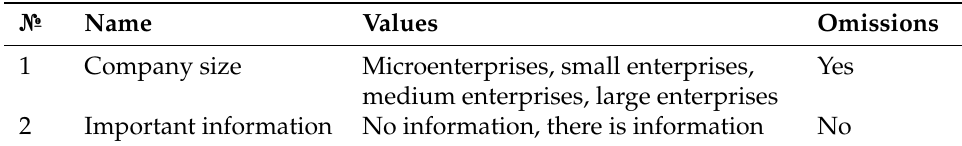
Table 3. Description of input data (Data in text